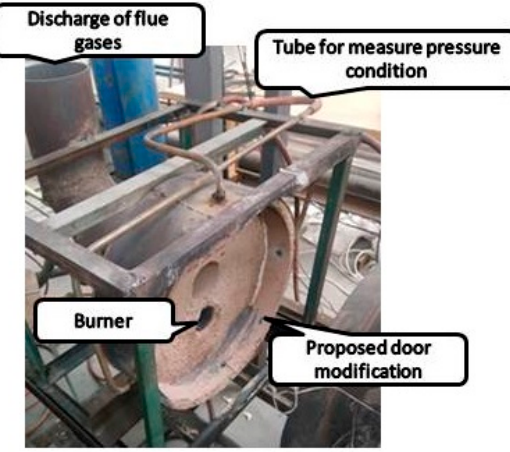
Figure 3. Door of the experimental furnace model.